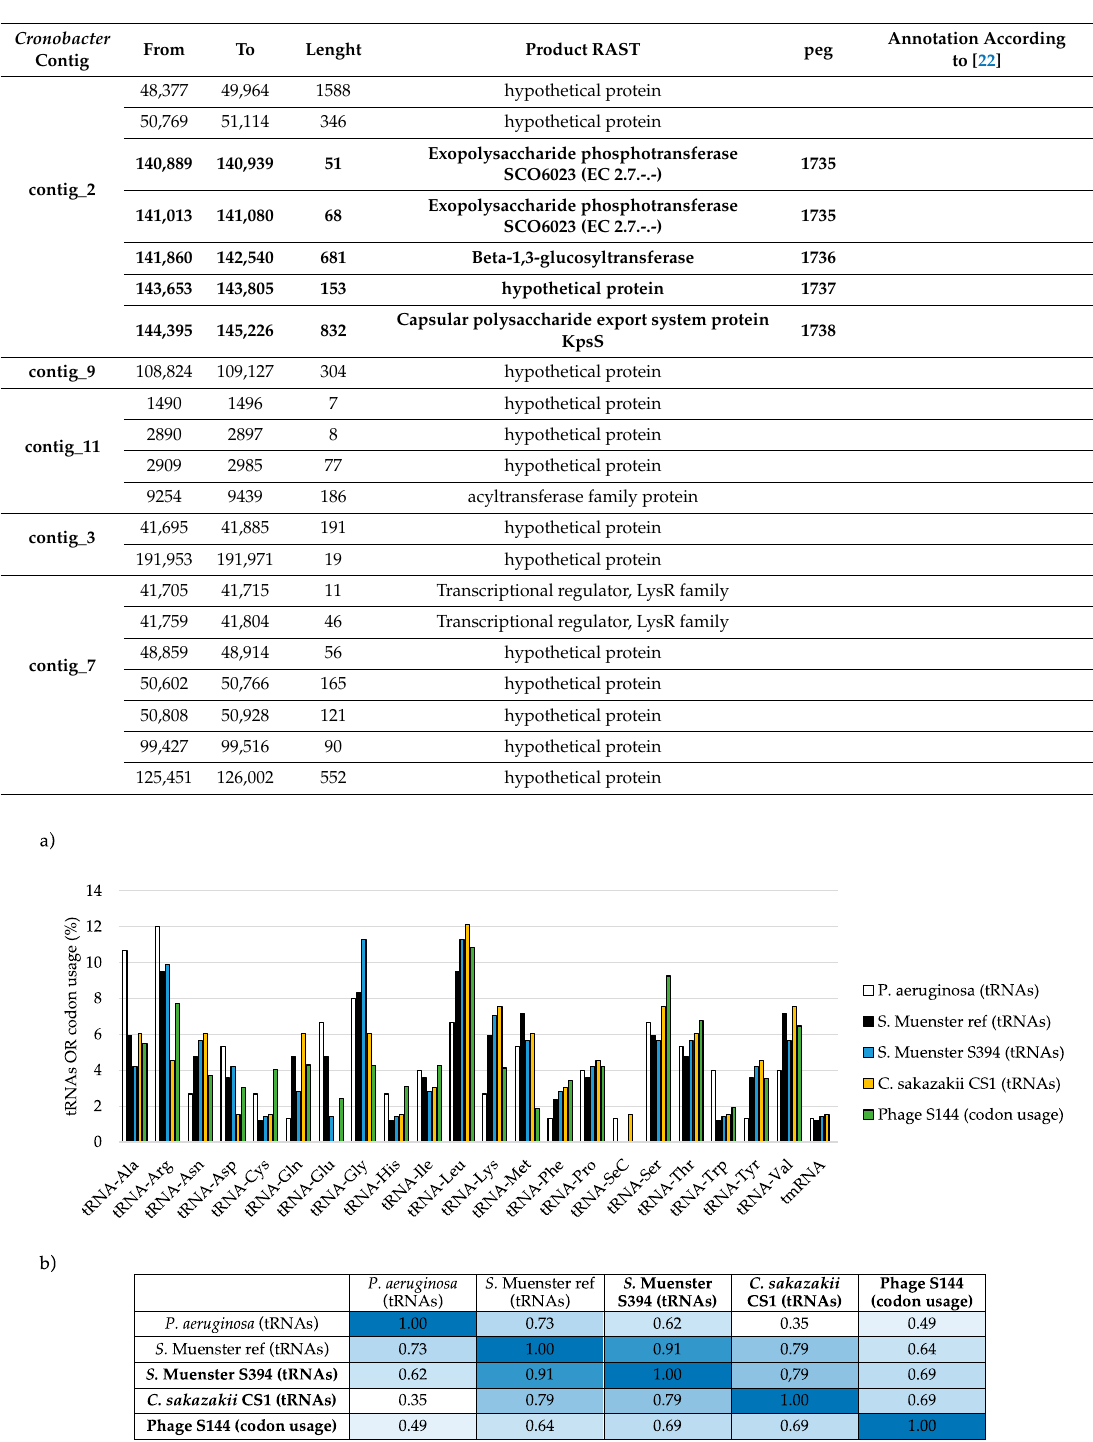
Figure A3. Correlation between hosts tRNA pool and codon usage in phage S144. ( a ) Presence of encoded tRNA synthesis genes in the hosts genomes ( S. Muenster S394; C. sakazakii CS1) and codon usage in phage S144, expressed as percentage over the total. The presence of tRNAs synthesis genes was also established in a deposited complete genome sequence of S. Muenster (NZ_CP019201) to exclude bias from having not full genome sequences. In addition, the tRNAs pool was analysed also in the P. aeruginosa PAO1 complete genome (NZ_CP053028) as a non Enterobacteriaceae control strain. ( b ) correlation table between bacteria tRNA pool and codon usage in phage S144.